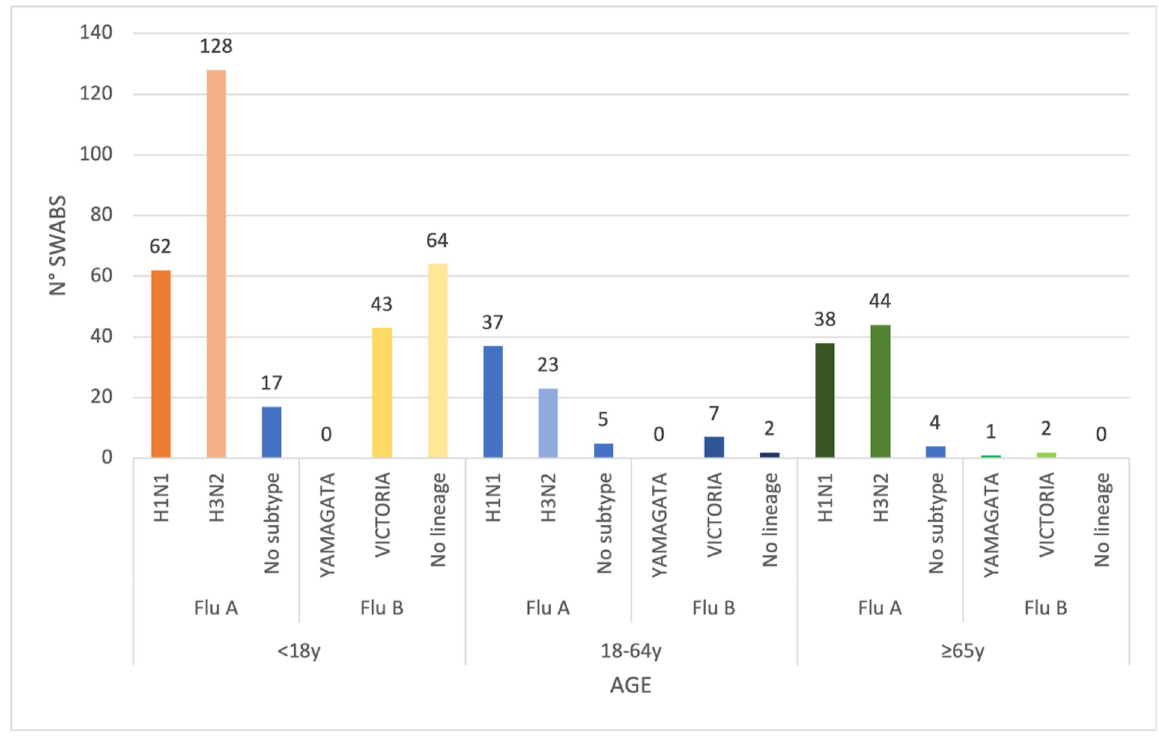
Fig 2. Positive sample distribution by influenza type/subtype or lineage and